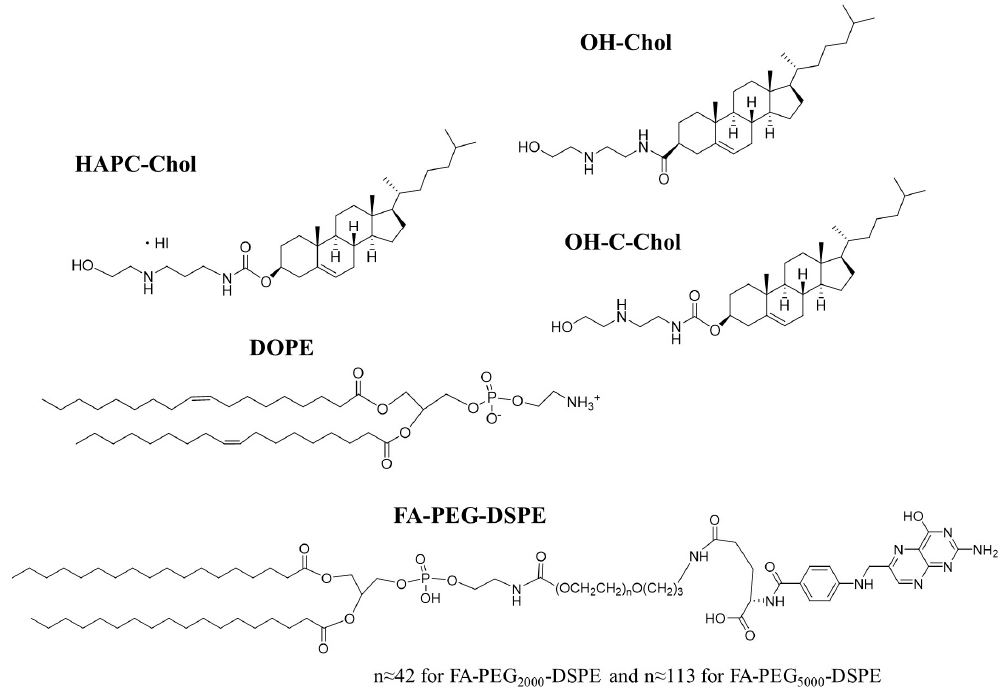
Figure 1. Structure of cationic cholesterol derivatives, neutral helper lipid, and FA-PEG-DSPE: HAPC-Chol; cholesteryl (3-((2-hydroxyethyl)amino)propyl)carbamate hydroiodide, OH-Chol; N -(2-(2-hydroxyethylamino)ethyl)cholesteryl-3-carboxamide, OH-C-Chol; cholesteryl (2-((2-hydroxyethyl)amino)ethyl)carbamate, DOPE; 1,2-dioleoyl- sn -glycero-3-phosphoethanolamine, FA-PEG-DSPE; FA-PEG-distearoylphosphatidylethanolamine.